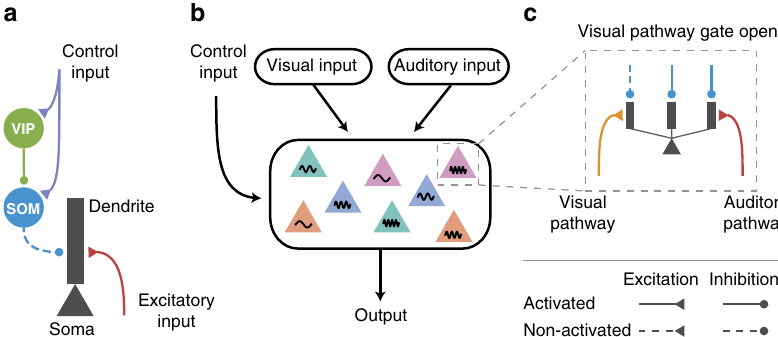
Figure 1 | Dendritic disinhibitory circuit as a mechanism for pathway-specific gating. ( a ) Subcellular microcircuit motif for gating through dendritic disinhibition. Dendrites of pyramidal neurons are inhibited by SOM interneurons, which are themselves inhibited by VIP interneurons. A control input (representing a context or a task rule) targeting VIP interneurons (and potentially SOM neurons) can thereby disinhibit pyramidal neuron dendrites, opening the gate for excitatory inputs targeting these dendrites. ( b ) Circuit configuration for pathway-specific gating. Pyramidal neurons receive converging inputs from multiple pathways, for example, visual and auditory. Single neurons in these areas are selective to multiple stimulus features, indicated here by colour and frequency. The processing of each pathway is regulated by the control input. ( c ) Inputs from different pathways target distinct subsets of dendrites of these pyramidal neurons. A pathway can be gated-on by specifically disinhibiting the dendrites that it targets, corresponding to an alignment between excitation and disinhibition. Disinhibition is represented by dashed